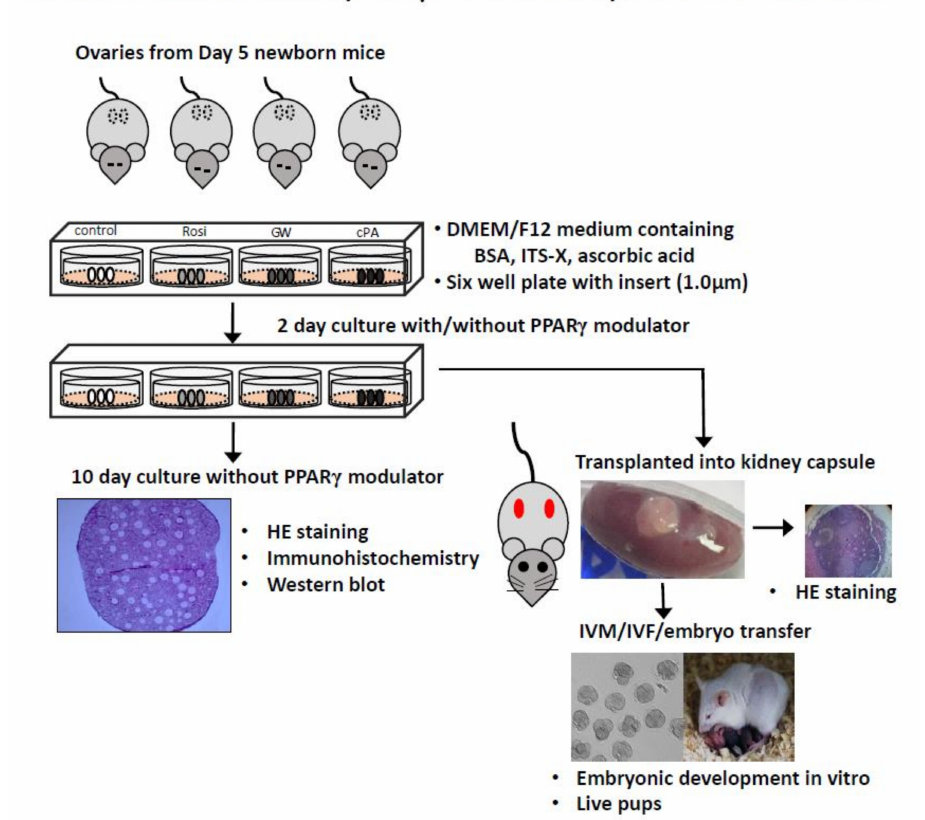
Figure 1. Schematic description of the experimental design. A cartoon shows in vitro co-culture with peroxisome proliferator-activated receptor gamma (PPAR γ ) modulators and ovarian transplantation with in vivo